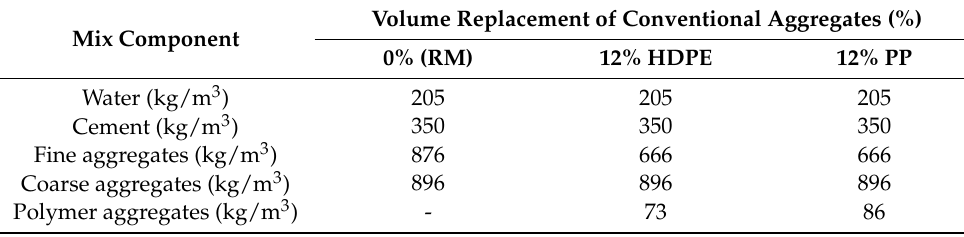
Figure 2. Schematic representation of the cylindrical concrete specimen. Table 1. Proportions for concrete